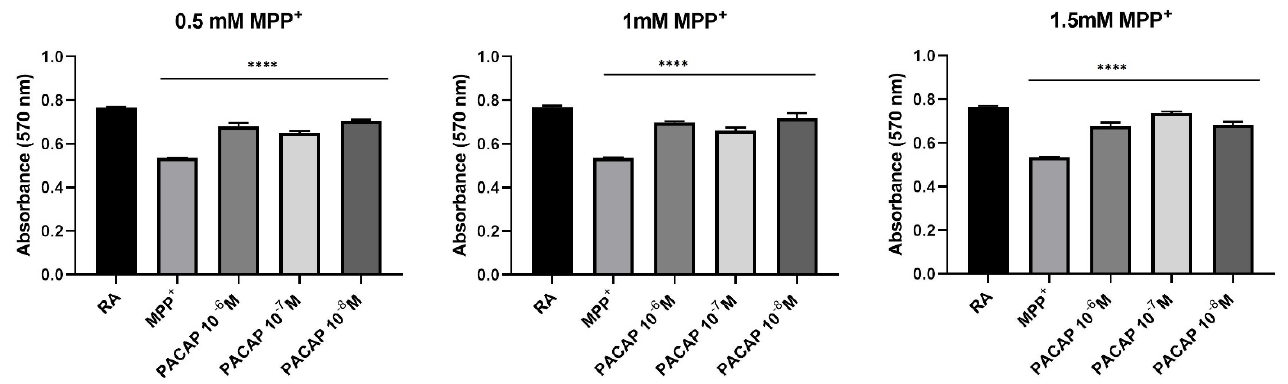
Figure 2. Spectrophotometric analysis on the effects of PACAP on cell viability following MPP + treatment on dopaminergic neurons (SH-SY5Y/RA). The results show exposure after 24 h. The graph shows the means ± SEM of three experiments. Statistical analysis was performed through the analysis of variance (ANOVA) and the Dunnet’s post-test. Values were considered significant, compared to the control MPP + . **** p < 0.0001.